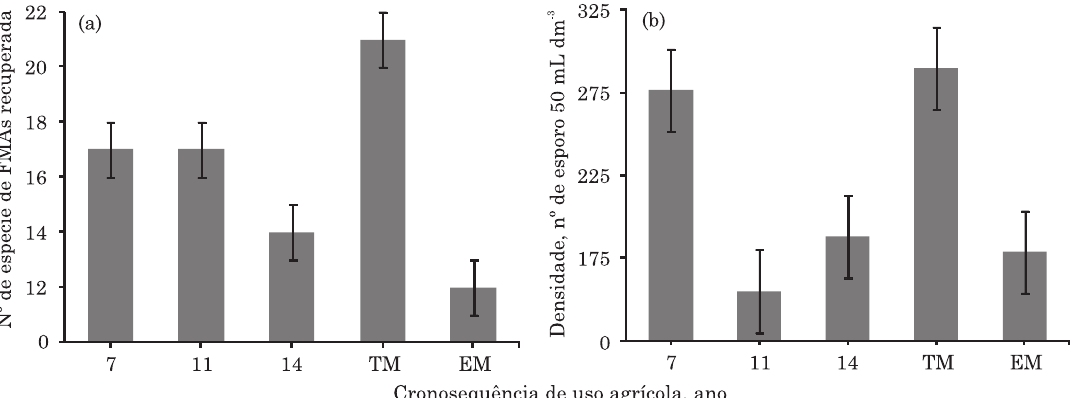
Figura 1. Número de espécies (a) e densidade de esporos (b) de FMAs nas áreas de uso agrícola (7, 11 e 14 anos) e sem alteração antrópica. TM: topo dos murundus; e EM: entre os murundus. Barras referem-se à DMS a 5 % pelo teste de